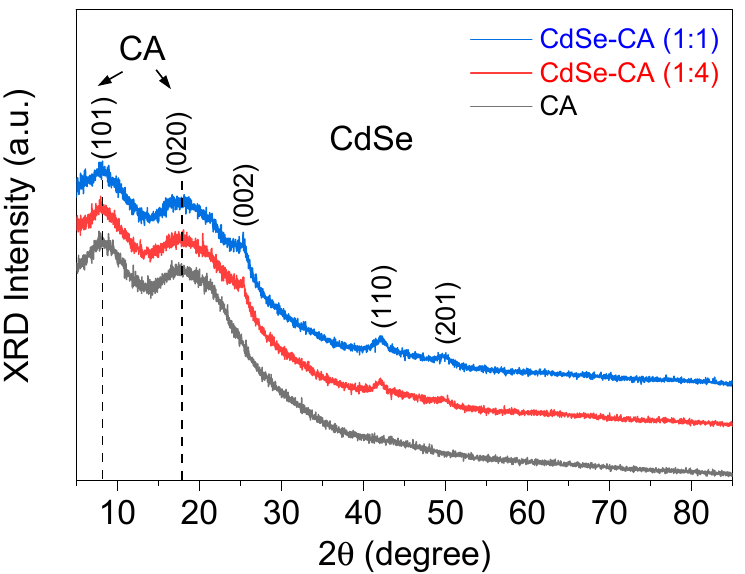
Figure 3. X-ray diffraction patterns of CA, CdSe-CA (1:4), and CdSe-CA (1:1) fibers.